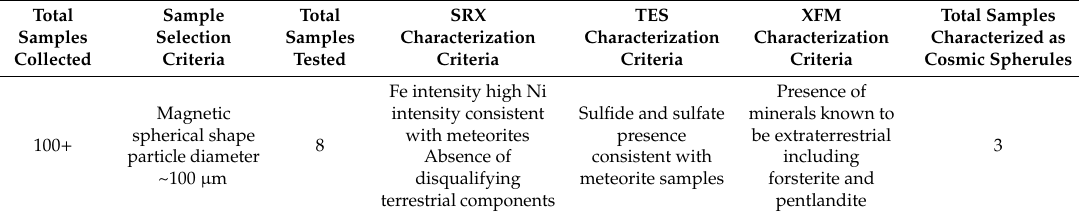
Table 2. Total samples collected and characterized as extraterrestrial in origin after synchrotron